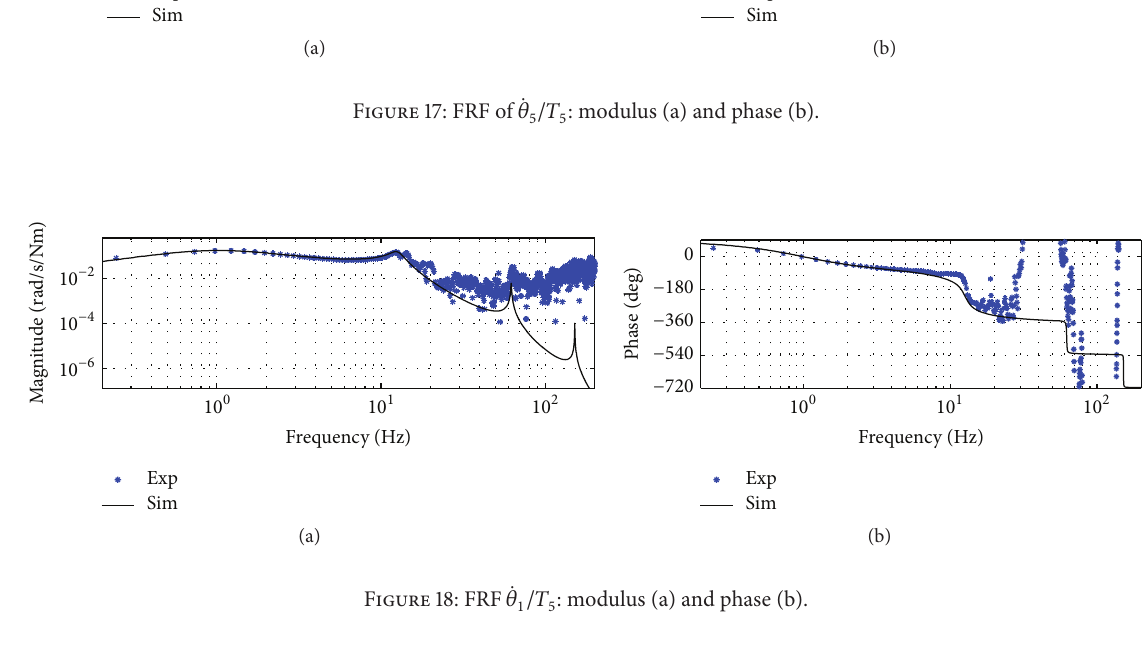
Figure 17: FRF of